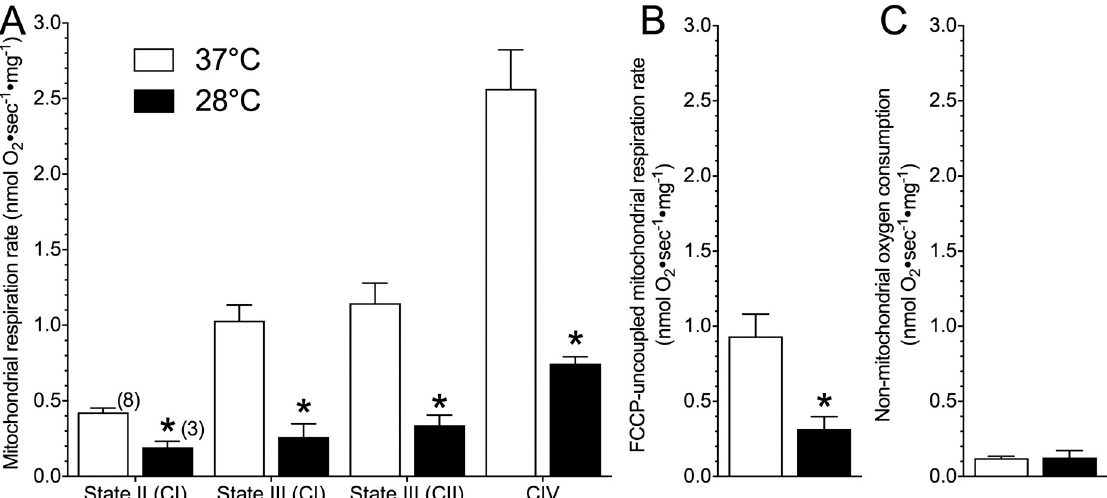
Fig 1. Mouse brain mitochondria have lower respiratory flux at a hypothermic temperature relative to physiological temperature. (A) State II (through complex I; pyruvate, malate and glutamate-fueled), state III (through complex I, ADP-fueled), state III (through complex II, succinate-fueled in the presence of rotenone), and complex IV respiratory rates from permeabilized brain mitochondria treated at physiological temperature (37˚C; white bars) or a hypothermic temperature (28˚C; black bars) normalized per mg protein in brain. (B) Comparison of complex I and II fueled FCCP-uncoupled respiration rates between experimental temperatures. (C) Comparison of non- mitochondrial oxygen consumption between experimental temperatures. Data are mean ± SEM. Numbers in parenthesis indicate n . Asterisks ( � ) indicate significant differences between physiological and hypothermic temperatures (p < 0.05; see Results section for statistical tests).